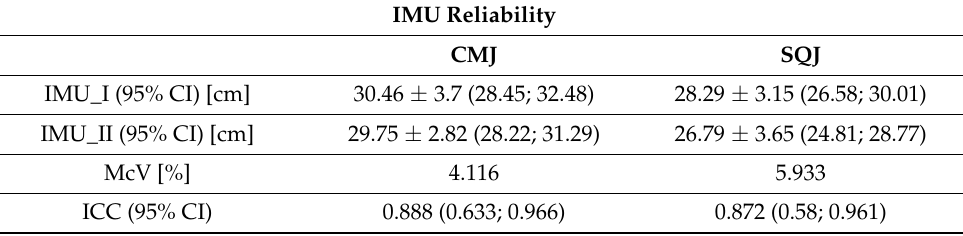
Table 3. Test-retest reliability of an inertial measurement unit (IMU) for vertical jump height